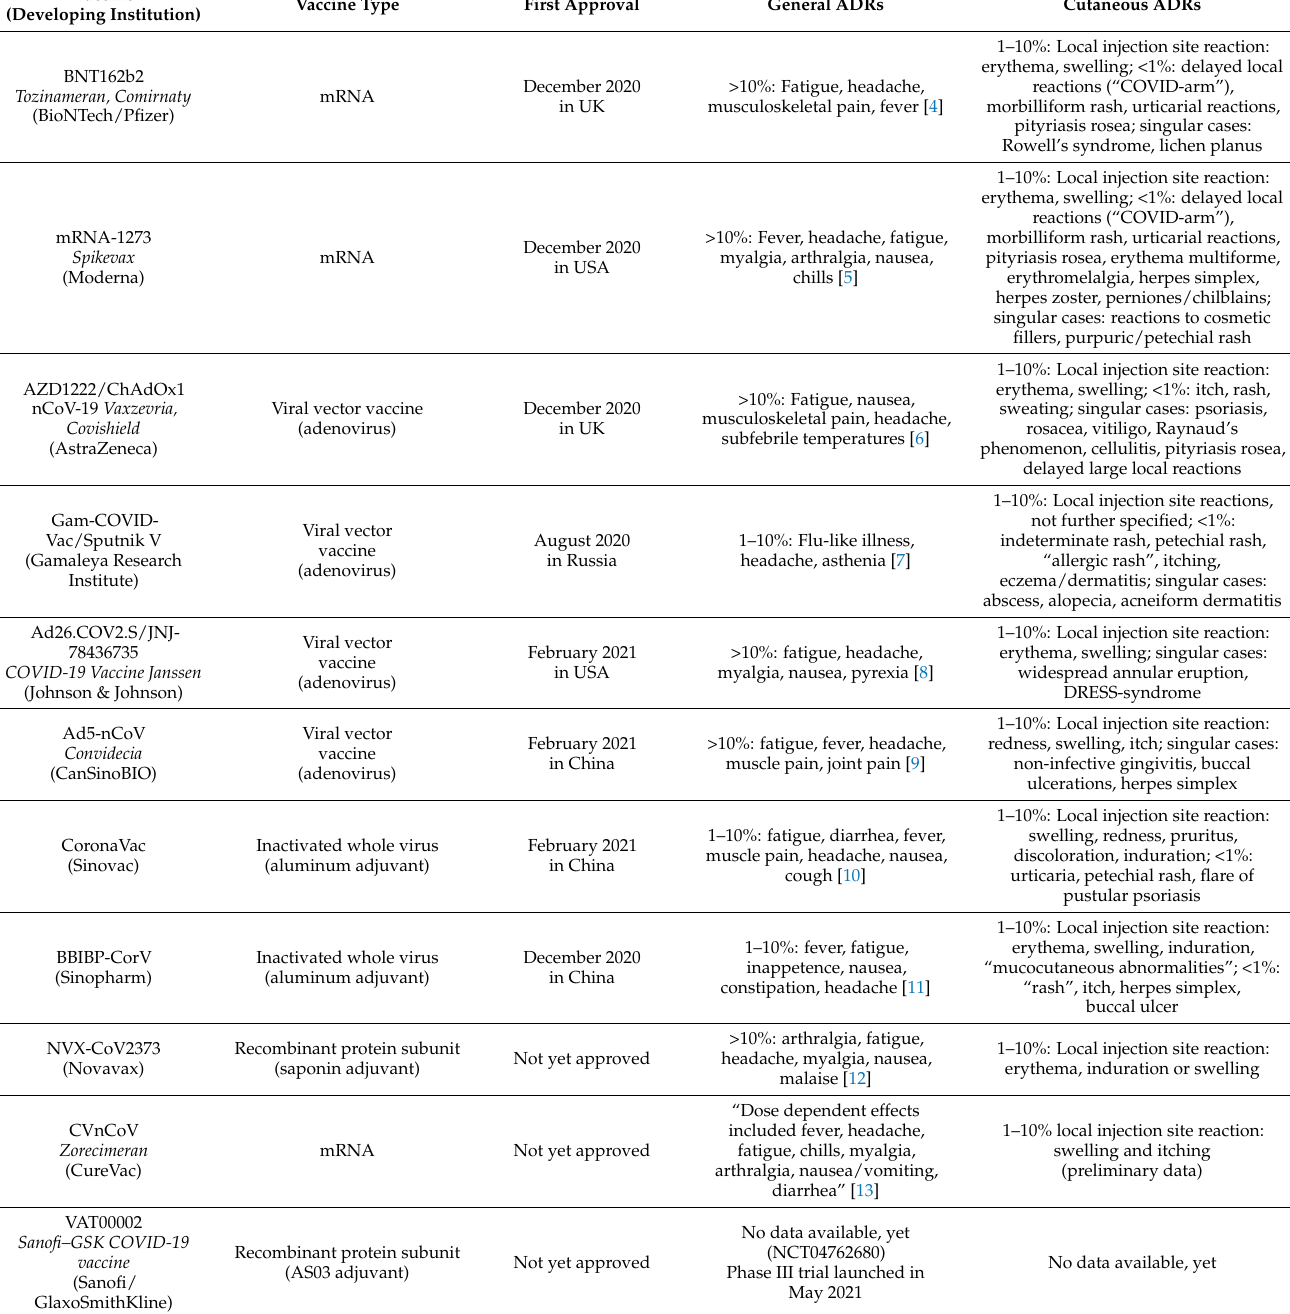
Table 1. Selection of COVID-19 vaccines and the most common ADRs, with a focus on cutaneous side effects, as of July 2021. Pain or tenderness at the injection site is very common with all available agents, and is therefore excluded in this tabular overview. Please note that further vaccines have entered clinical trials [3]. Abbreviations: mRNA—messenger ribonucleic acid; UK—United Kingdom; USA—United States of America; DRESS—drug reaction with eosinophilia and systemic